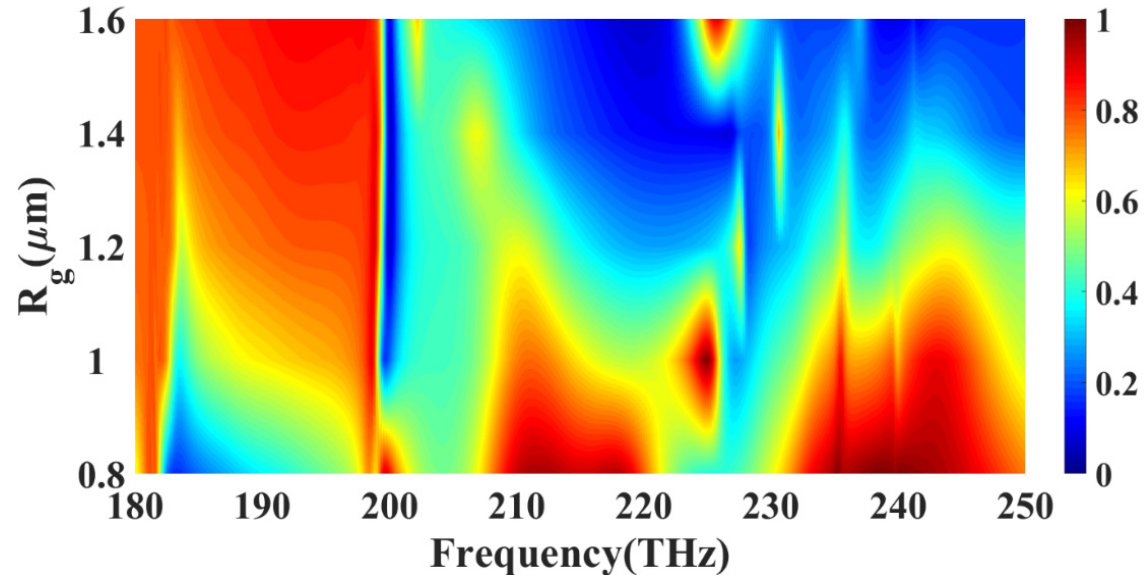
Figure 4. Calculated absorption response for the different size values of the squared silver resonator.